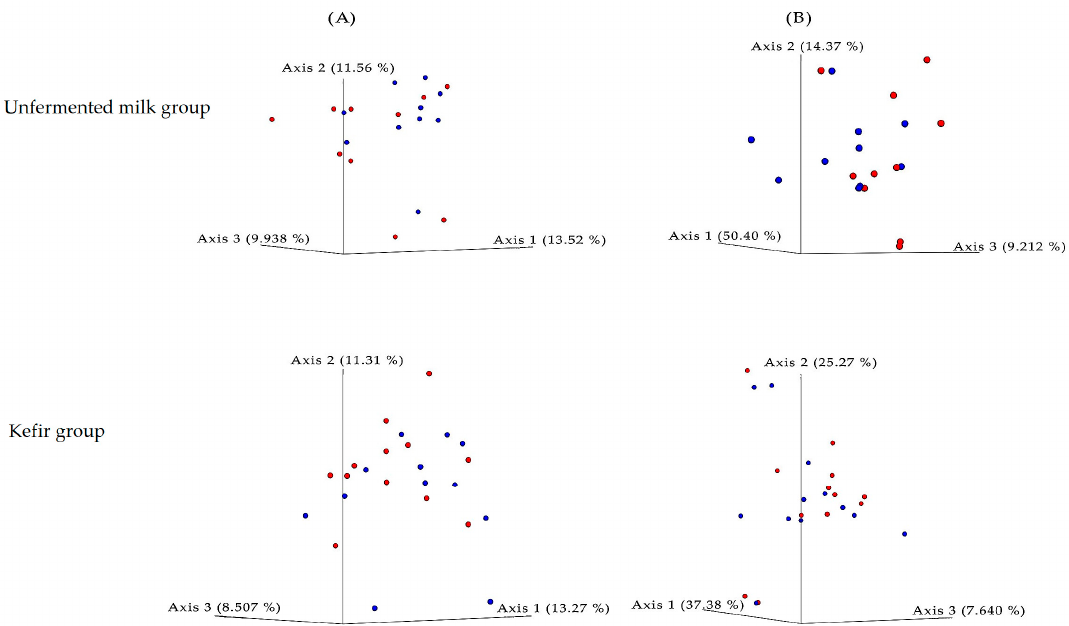
Figure 5. Principal coordinate analysis (PCoA) plot of the unweighted ( A ) and weighted ( B ) UniFrac distance matrices in the study groups. The plots were generated using EMPeror [36]. Axis titles indicate the percentage variations. The colors indicate sampling time (red: week 0, blue: week 12).